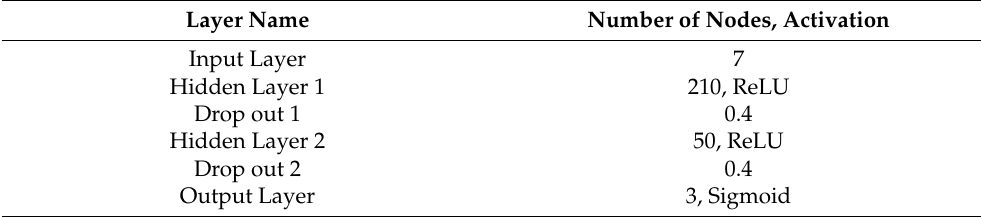
Table 1. Detailed structure of DNN model.